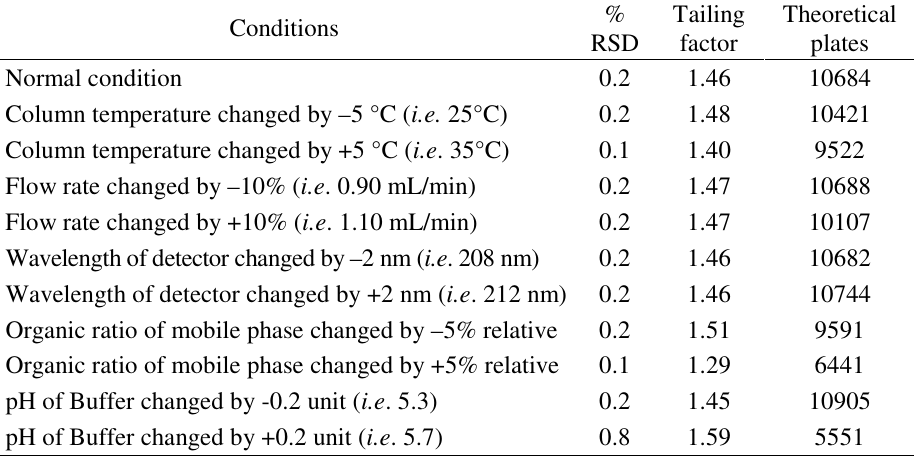
Table 2. Data of robustness study for